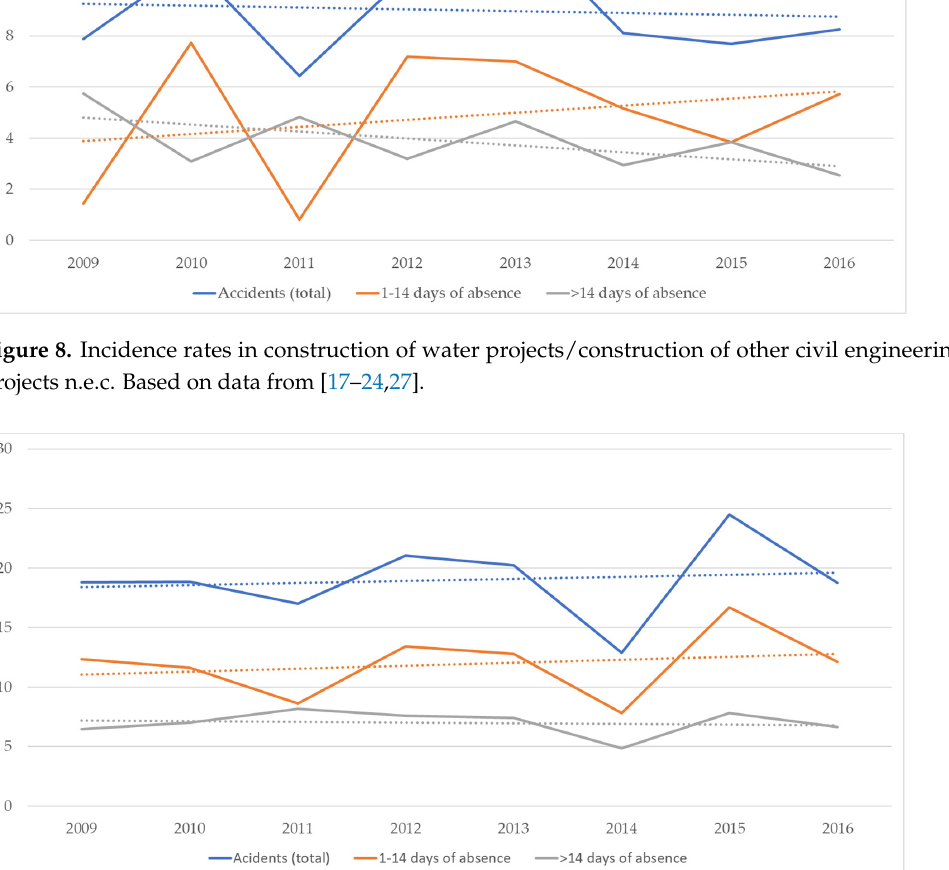
Figure 9. Incidence rates in construction of utility projects for fluids/construction of utility projects for electricity and telecommunications. Based on data from [17 – 24,27] .